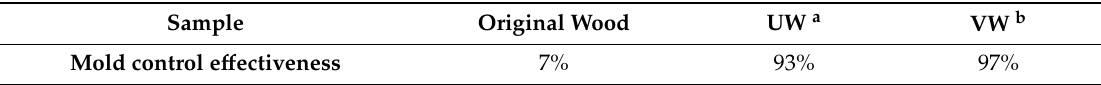
Table 1. The effectiveness of mold control.